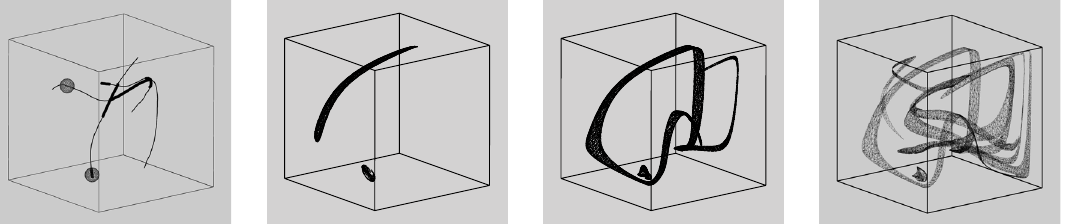
Figure 3 a, b, c, d (fromf the two material volumes after one, two, and th left to right): 3a shows two material blob placed around a hyperbolic and an elliptic periodic point for the F B F B protocol r u l d with D = 5. Sub-figures (b), (c), and (d) show the deformation oree periods,